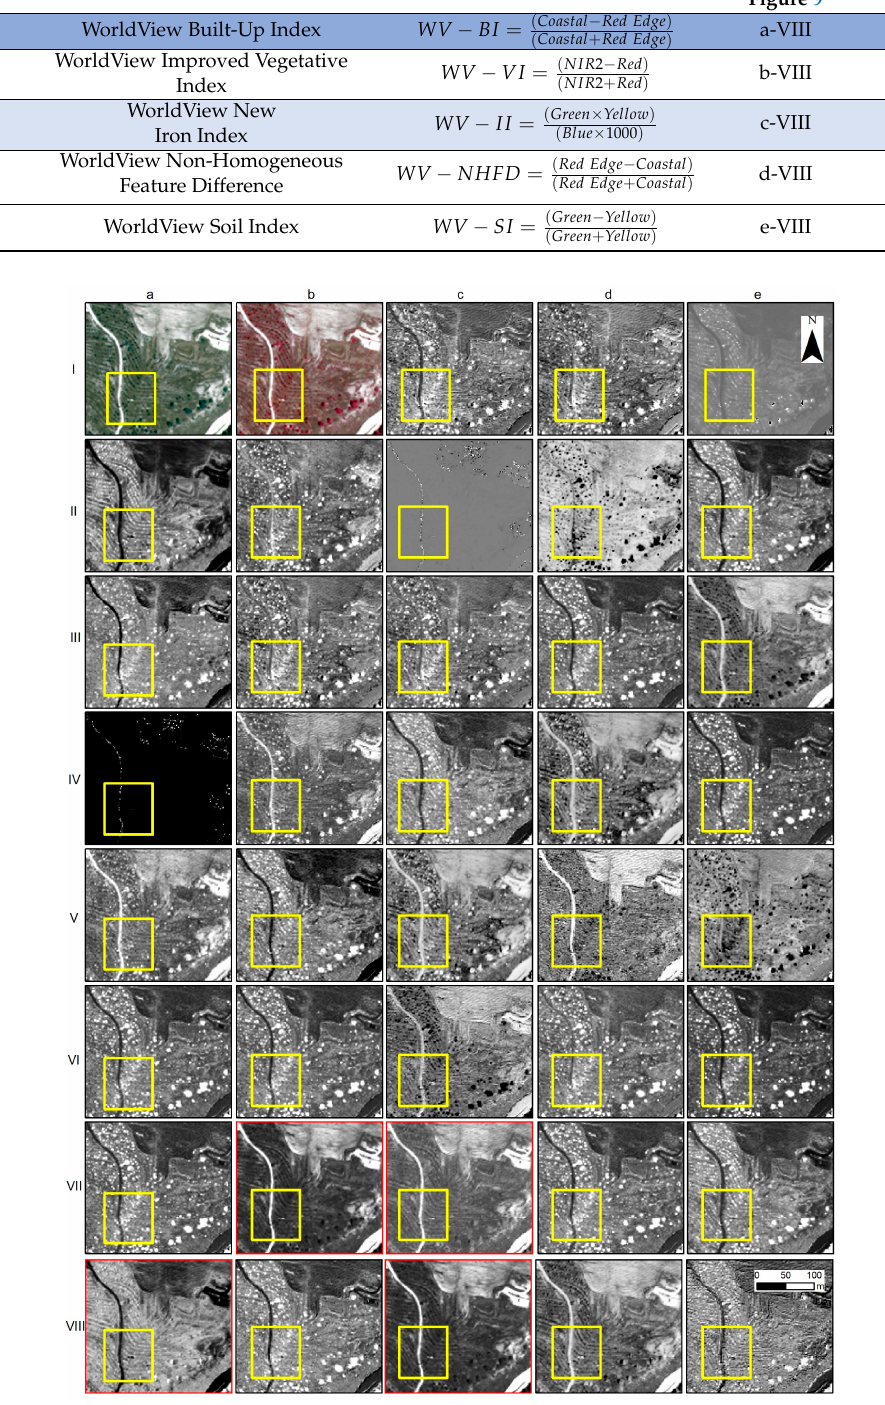
Figure 9. RGB pseudo-color composite 5-3-2 and NIR-R-G pseudo-color composite 6-5-3 are demonstrated in a-I and b-I . The rest sub-figures ( c-I ; d-I ; …. d-VIII and e-VIII ) correspond to the greyscale indices (see Table 2; total 38 indices) results applied in the WorldView-2 image. The looted area is shown in the yellow square. Images with a red outline show promising vegetation indices (i.e., b-VII ; c-VII ; a-VIII ; and c-VIII ).